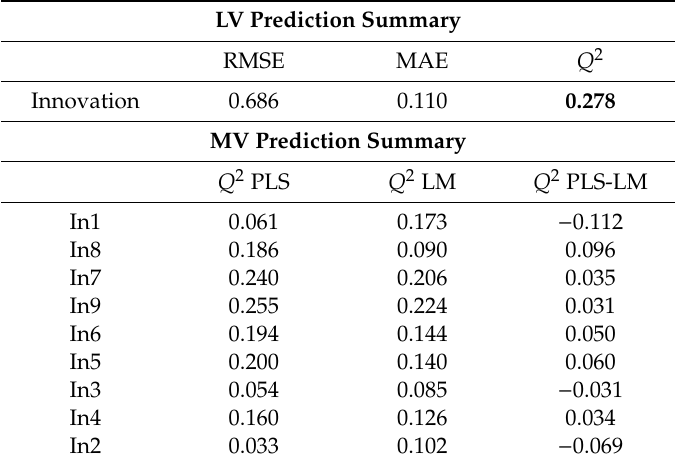
Table 3. Predictive performance